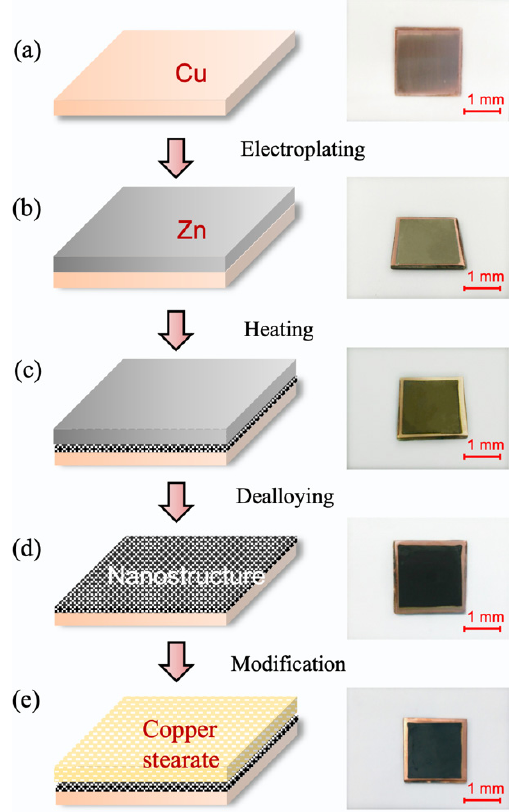
Figure 1. Schematic preparation procedure and photographs of superhydrophobic copper surface at each step, ( a ) preprocessing; ( b ) electroplating; ( c ) heating; ( d ) dealloying; and ( e ) modification.